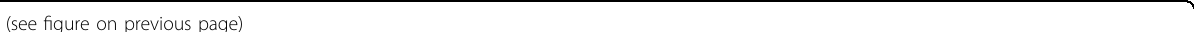
Fig. 1 Dose-response and duration-dependence of the effect of rarely used before (10 pM – 10 nM) rotenone concentrations on cellular and mitochondrial parameters. Results expressed in percentage of control (vehicle-treated) represent means ± SEM of three independent experiments, each in triplicate. A Cell viability (MTT assay). Control value was: 0.336 ± 0.034 OD 540nm . Fisher ’ s LSD post hoc test: *1000 pM rotenone differed signi fi cantly from the control: p < 0.02 for 24 and p < 0.007 for 48; **10 nM rotenone: p < 0.004 for 24 h and p < 5E − 06 for 48 h; ***100 nM rotenone: p < 0.02 for 24 h and p < 4E -07 for 48 h. B Mitochondrial respiration parameters. Results in pmoles O 2 consumed/min/mg protein converted into % of control. Control values: basal OCR – 2.3 ± 0.8; ATP-linked OCR – 2.08 ± 1.1; non-mitochondrial respiration – 1.85 ± 1.16. One result exceeding ±2SDs was excluded. Basal OCR: *48 h, ANOVA: F 4,7 = 14.2, p = 0.001; post hoc Fisher ’ s LSD test: 10, 10 3 , and 10 4 pM rotenone (Rot.) vs . control, p < 0.02. ATP-linked OCR: *24 h, ANOVA: F 4,10 = 5.1, p = 0.01; post hoc Fisher ’ s LSD test: 10 4 pM (Rot.) vs . control, 10 and 10 2 pM, p < 0.03. **48 h, ANOVA: F 4,9 = 8.9, p = 0.003; post hoc Fisher ’ s LSD test: 10, 10 3 , and 10 4 pM (Rot.) vs . control, p < 0.03. Non-Mitochondrial respiration: *48 h, ANOVA: F 4,8 = 6.7, p = 0.01; post hoc Fisher ’ s LSD test: all (Rot.) concentrations vs . control, p < 0.04; 10 4 pM rotenone vs . 10 and 10 2 pM, p < 0.05. C – G. ROS levels. Results of fl uorescence intensity, (>30 cells analyzed/well) ± SEM. Control ROS values were 555 ± 59 a.u. A gradual increase in ROS levels in a dose-response and time-dependent manner was observed, presented in representative images (Hoechst and mitosox staining - C ) and bar-graphs ( D – G ). D 10 pM rotenone: Fisher ’ s LSD post hoc test: *6 h, a signi fi cant decrease in ROS levels vs . all treatments, p ≤ 0.005. E 10 2 pM rotenone: Fisher ’ s LSD post hoc test: *48 h, a signi fi cant increase in ROS levels vs . control and 6 h, p < 0.03. F 10 3 pM rotenone: Fisher ’ s LSD post hoc test: *6 h, a signi fi cant decrease in ROS levels vs . all treatments, p < 0.02; **, ***24 and 48 h, respectively, a signi fi cant increase in ROS levels vs . control and 6 h, p < 0.02. G 10 4 pM (10 nM) rotenone: Fisher ’ s LSD post hoc test: *, **24 and 48, respectively, a signi fi cant increase in ROS levels vs. control and 6 h, p <